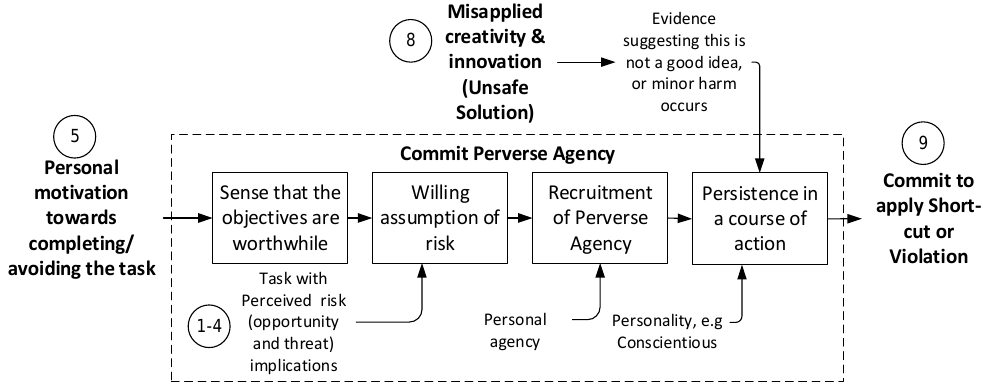
Figure 8. Perverse Agency and Over Alignment Model.